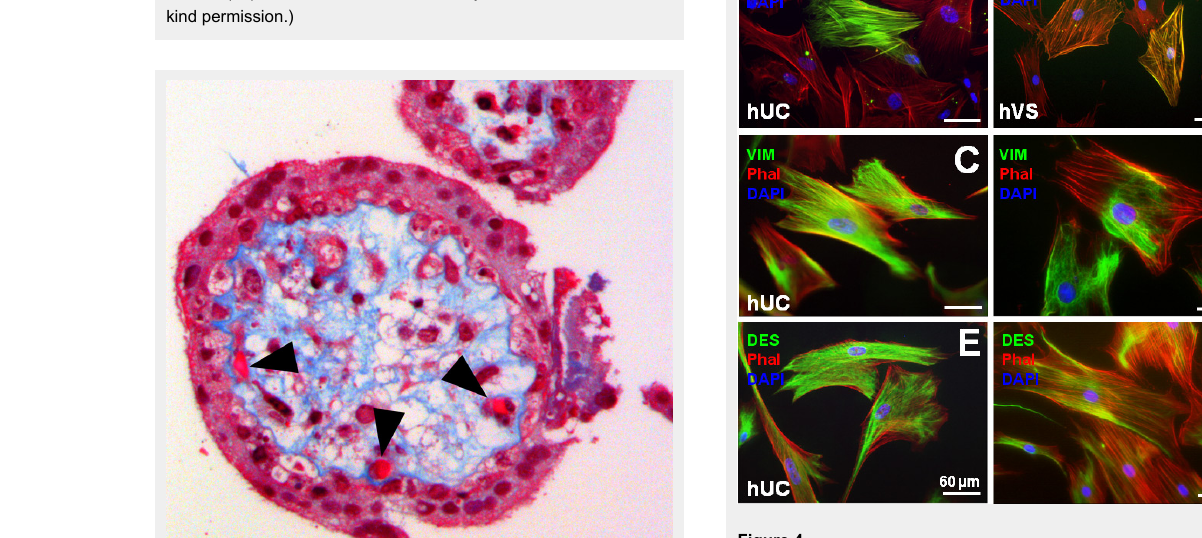
Bone marrow mononuclear cell-based tissue engineered heart valve prior to implantation into an animal model. (Reprinted from [23]: Weber B, Scherman J, Emmert MY, Gruenenfelder J, Verbeek R, Bracher M, et al. Injectable living marrow stromal cell-based autologous tissue engineered heart valves: first experiences with a one-step intervention in primates. Eur Heart J. 2011;32(22):2830–40. © Oxford University Press, Oxford, UK, with kind permission.)